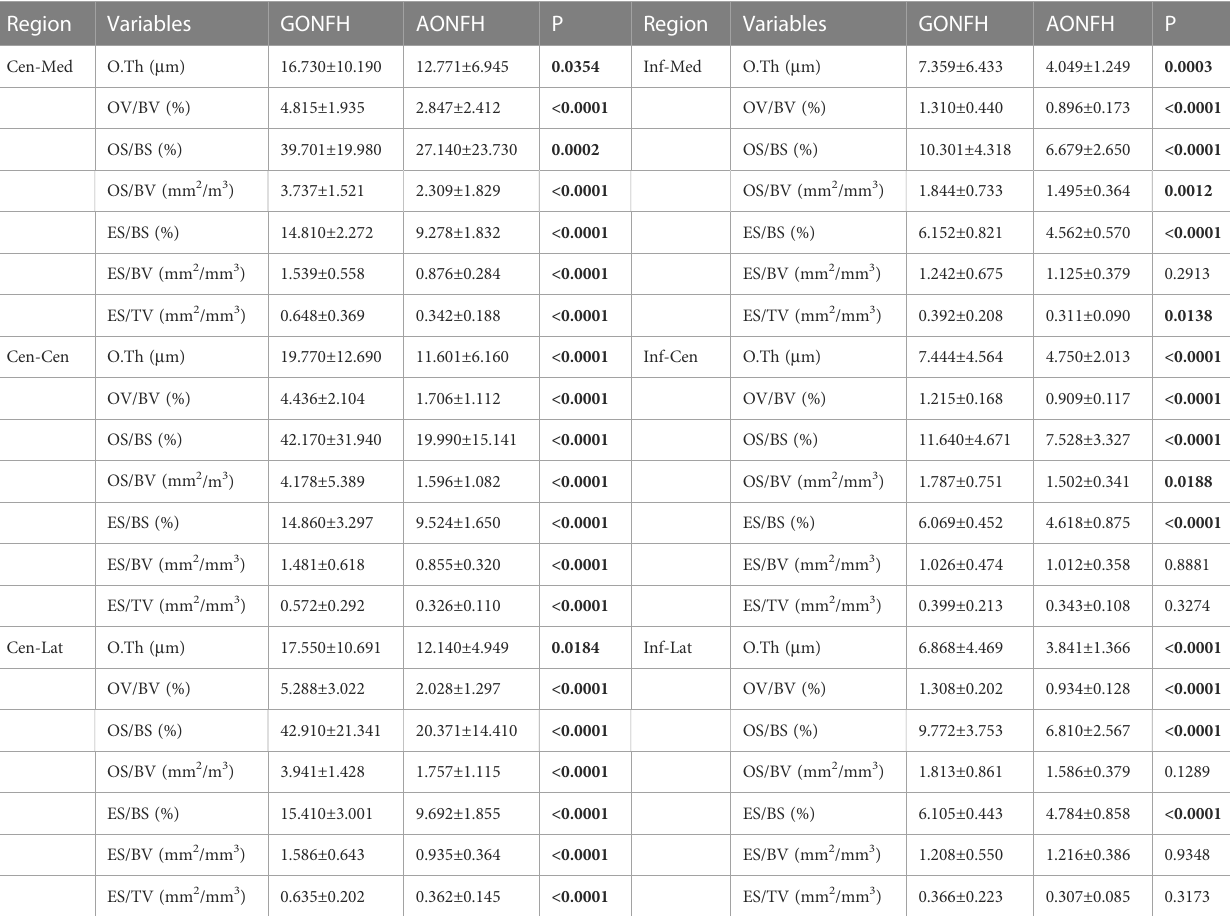
TABLE 3 Comparison of bone remodeling parameters in the reactive interface (Cen-Med region, Cen-Cen region, Cen-Lat region) and normal region (Inf-Med region, Inf-Cen region, Inf-Lat region) between GONFH and AONFH.